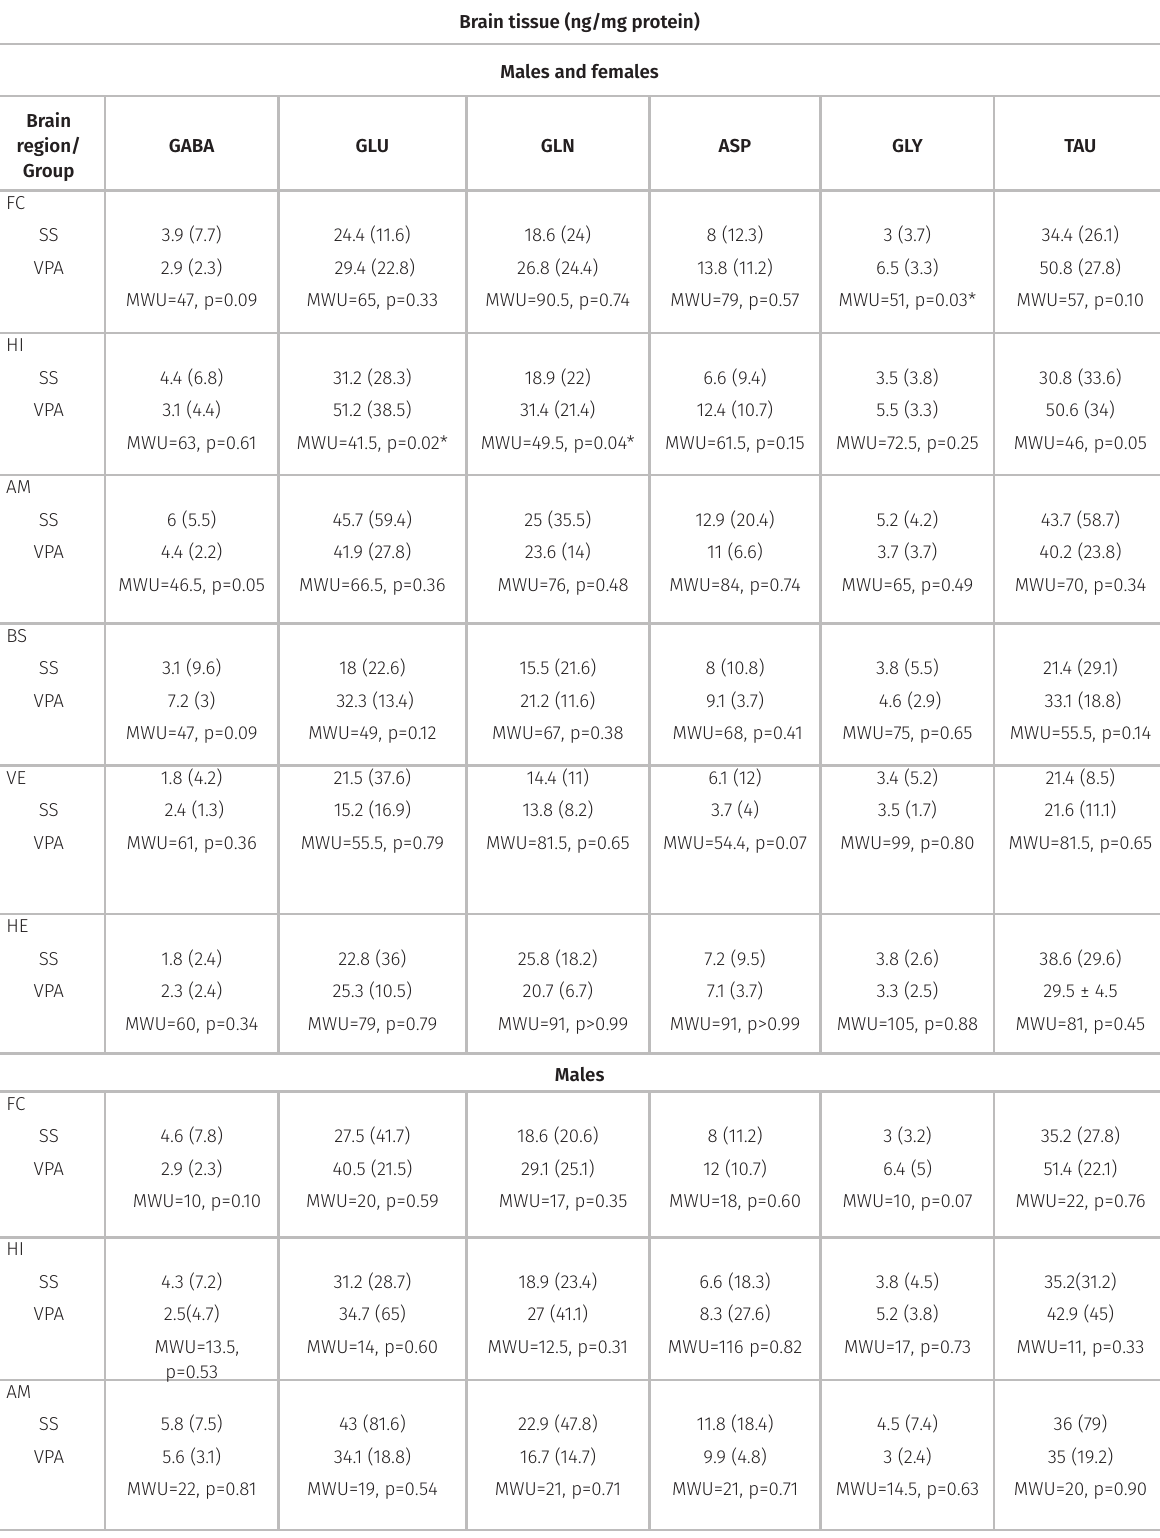
Table I. Effect of valproic acid prenatal exposure on brain tissue and plasma amino acid levels in rats. Brain tissue (ng/mg protein) Males and